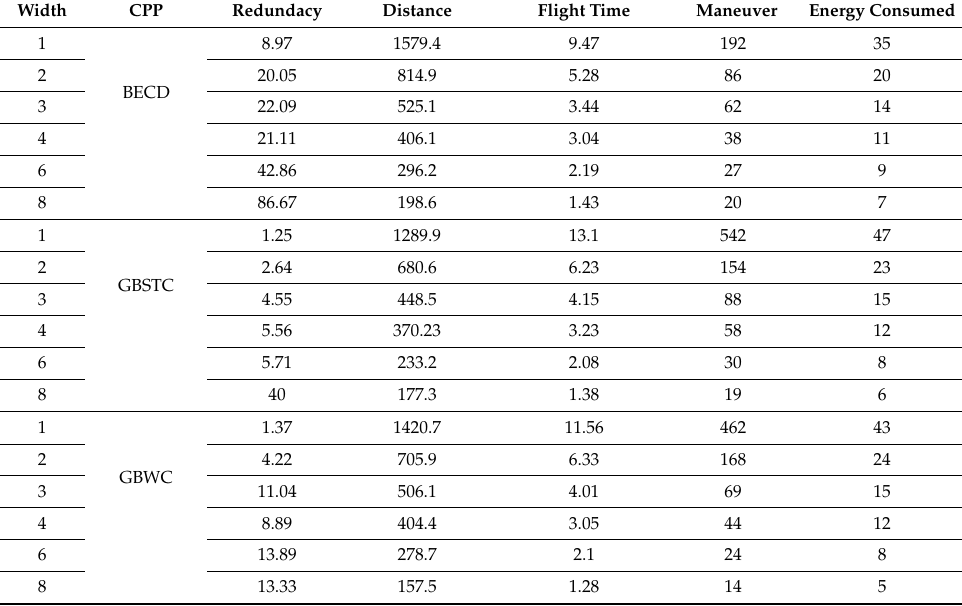
Table A4. Experiment 3 with three CPP methods implemented using Typhoon UAV over CSUSL PV Plant.